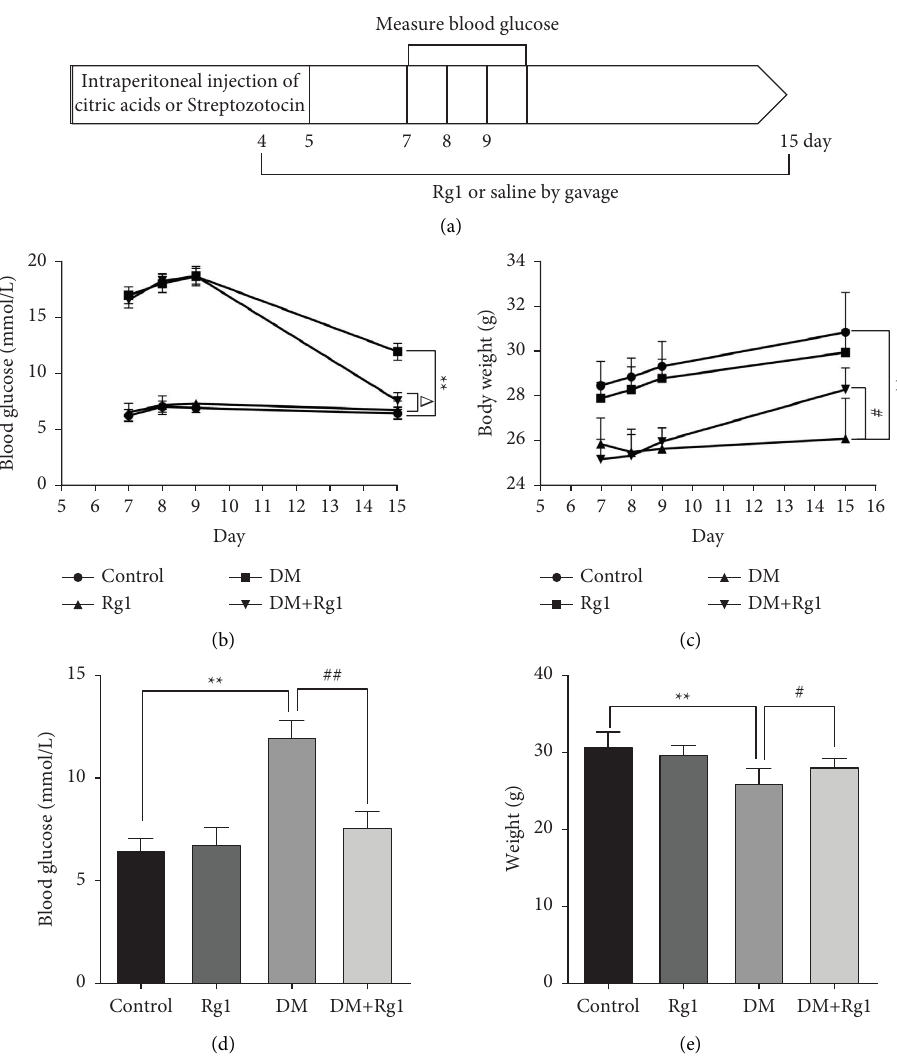
Figure 1: Efects of ginsenoside Rg1 (Rg1) on blood glucose and body weight in type 1 diabetes (T1D) mice. (a) Te time axis of animal treatment. (b, c) Changes in blood glucose and body weight on days 7, 8, 9, and 15 since the frst injection of streptozotocin (SZT). (d, e) Te statistical analysis of blood glucose and body weight in diferent groups on days 15 since the frst injection of SZT. Tose results suggested the T1D mouse models were successfully constructed, and Rg1 treatment improved blood glucose and body weight in T1D. (Mean ± SD, n � 6) ∗∗ p < 0 . 01, vs. the control group; Δ p < 0 . 05, vs. the Rg1 group; # p < 0 . 05, ## p < 0 . 01 vs. the DM